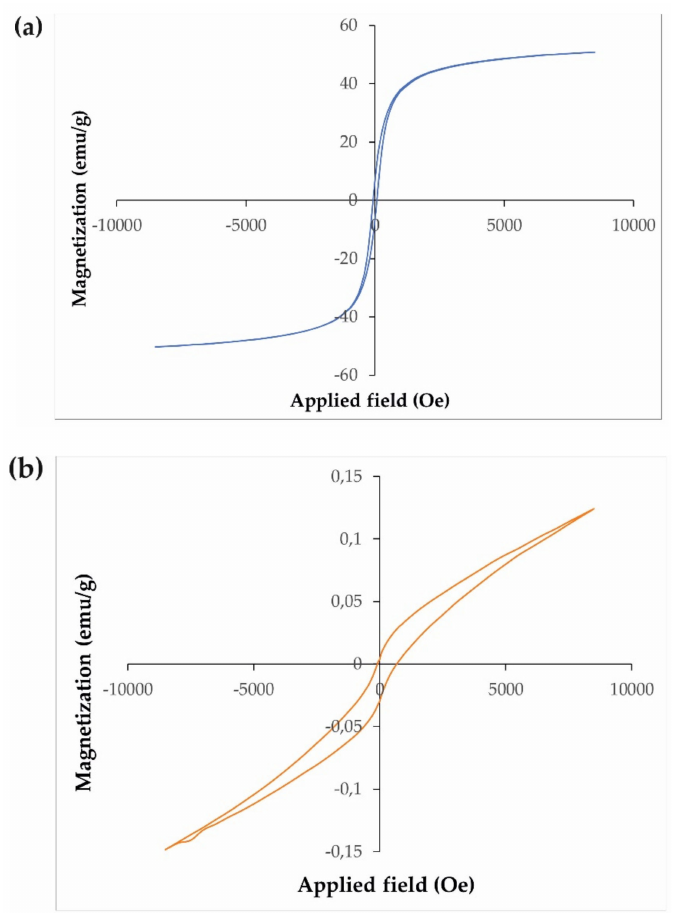
Figure 2. The magnetic hysteresis loops of the ( a ) Fe 3 O 4 and ( b ) Fe 3 O 4 / CdWO 4 / PrVO 4 (S4)